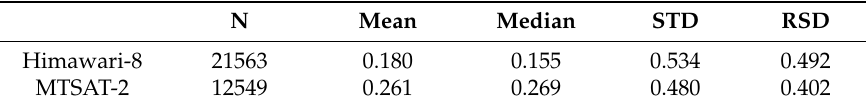
Table 5. Statistics of satellite SST—in situ temperatures (K). N